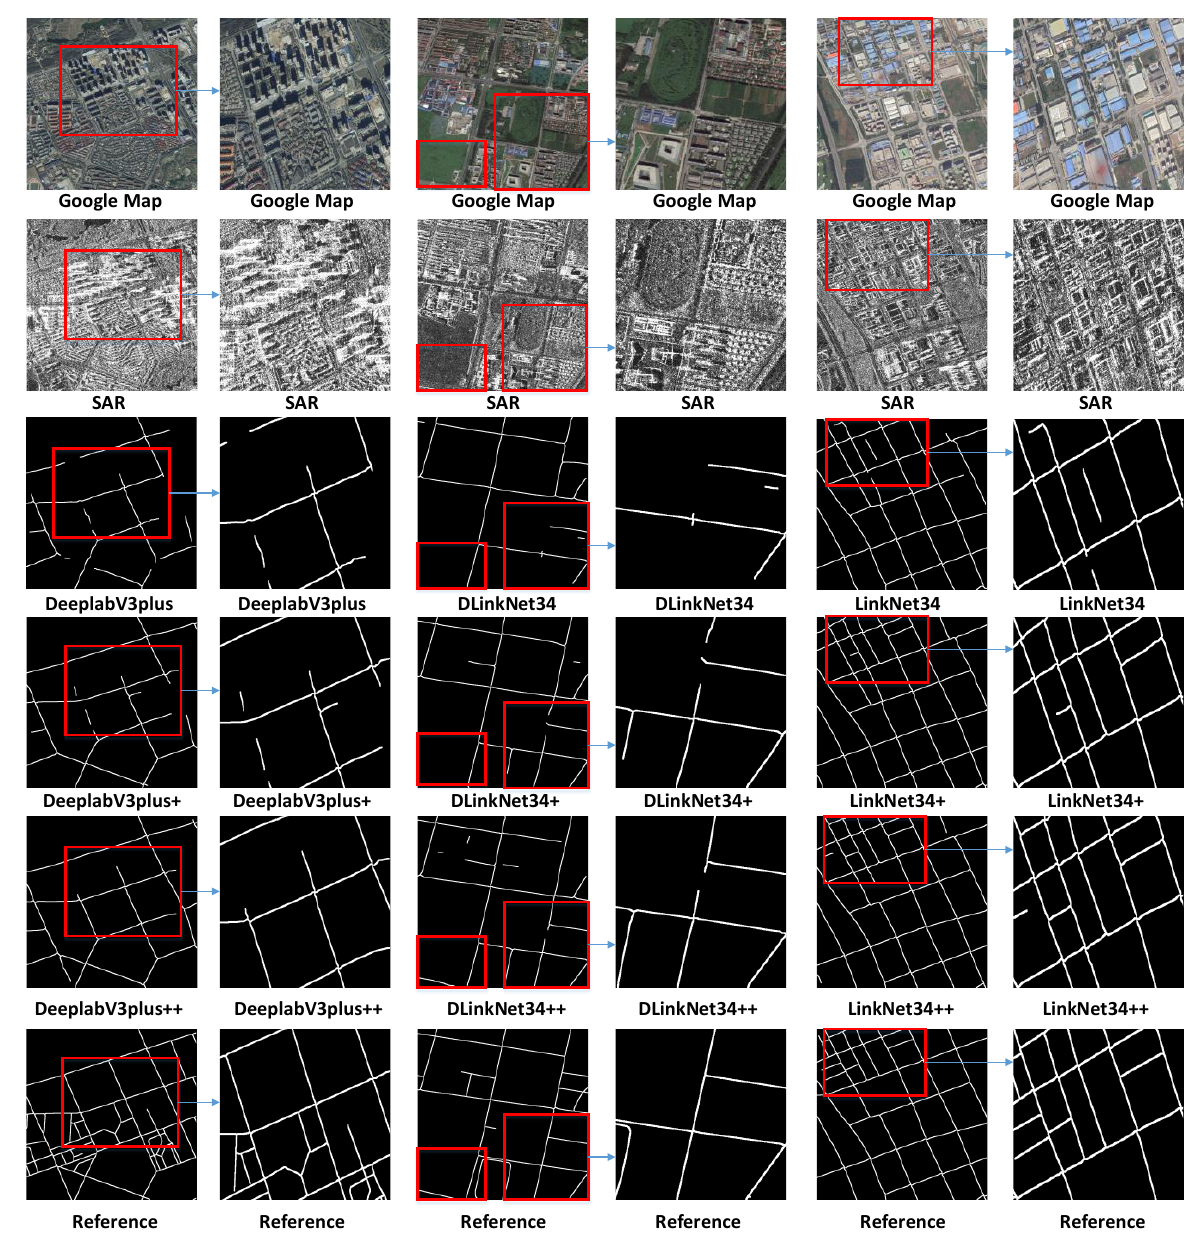
Figure 6. Qualitative comparison of road centerline extraction results produced by different methods. For visualization, we performe the morphological dilation operation on the road centerline extraction